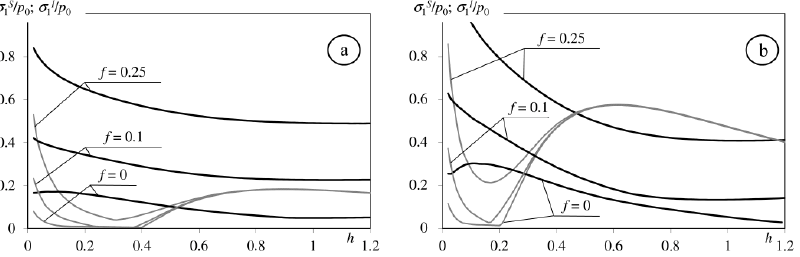
Figure 6. Dependence of the maximum tensile stress on the surface of the considered half-space σ 1S (black lines) and the interface between the homogeneous coating and base σ 1I (grey lines) to coating’s thickness ( a ): E 1 / E 0 = 2; ( b ): E 1 / E 0 = 4.